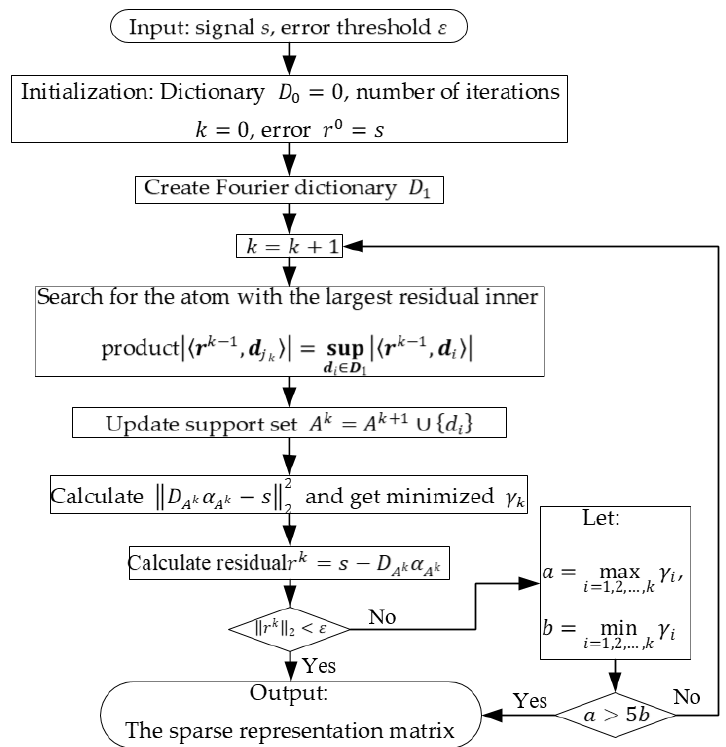
Figure 1. Adaptive OMP algorithm for separating harmonics and modulation components.